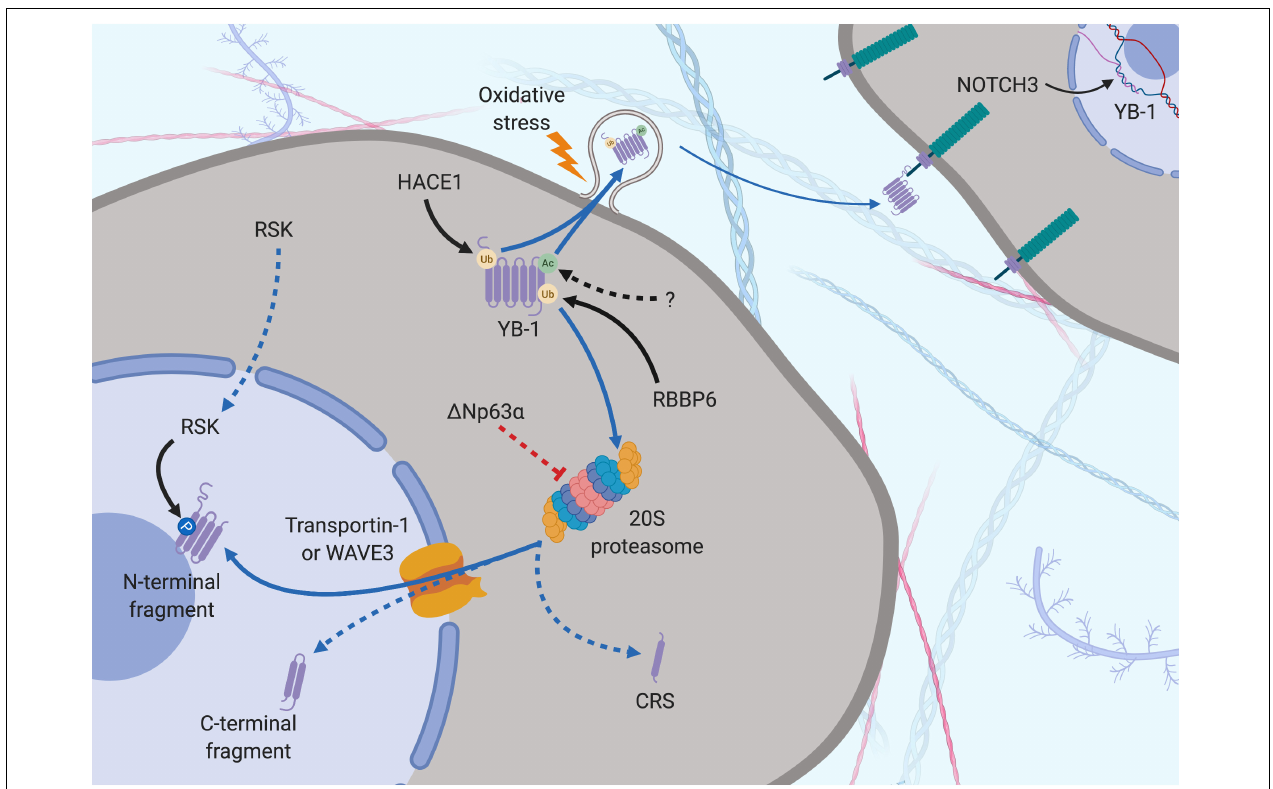
FIGURE 4 | Subcellular localization of YB-1 – the proteolytic theory of nuclear localization. YB-1 can be found in the nucleus, cytoplasm and extracellular space and its localization is mediated by various factors. Secretion can be preceded by Ubiquitination (orange dot) by HACE1 and acetylation (green dot) by a currently unknown protein. Oxidative stress stimulates stress-granule localization and eventual section of YB-1, where it can bind to the transmembrane protein Notch3 on other cells. YB-1 is cleaved by the proteasome prior to nuclear translocation. Ubiquitination by RBBP6 initiates YB-1 proteolytic cleavage. (cid:49) Np63 α prevents full length proteolysis by partially inhibiting YB-1 degradation, resulting in the removal of the CRS. Transportin-1 or WAVE3 bind to NLS of YB-1 and translocate it to the nucleus. RSK can cross into the nucleus, phosphorylating nuclear YB-1 fragments. Solid black arrows indicate a post-translational modification that is produced by a described or known mechanism. Dotted black arrows indicate a post-translational modification whose significance is yet to be realized. Blue and dotted blue arrows indicate the movement or supposed movement of YB-1 throughout cellular compartments, respectively. Created with